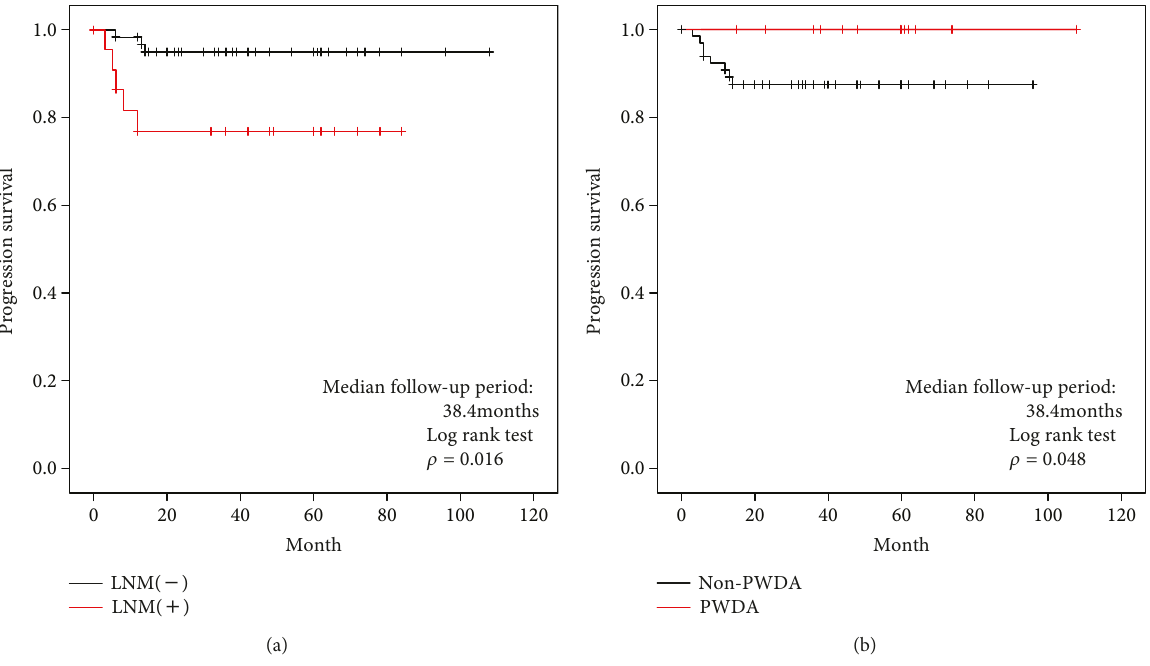
Figure 3: Time to tumor recurrence after operation strati fi ed by LNM and PDWA in T2 cancers. PWDA: pure well-di ff erentiated adenocarcinoma; LNM: lymph node metastasis. Table 4: The di ff erence in various clinicopathological factors between cases with and without PWDA among T1 colorectal cancers. PWDA Non-PWDA p value